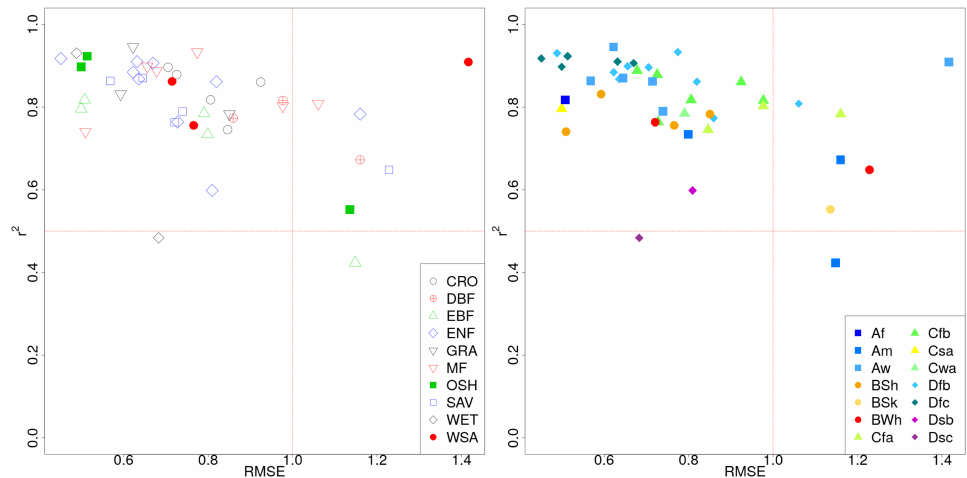
Figure 4. Scatterplot of r 2 and RMSE of simulated daily ET indicating the corresponding PFT ( left ) and the Köppen–Geiger climate class ( right